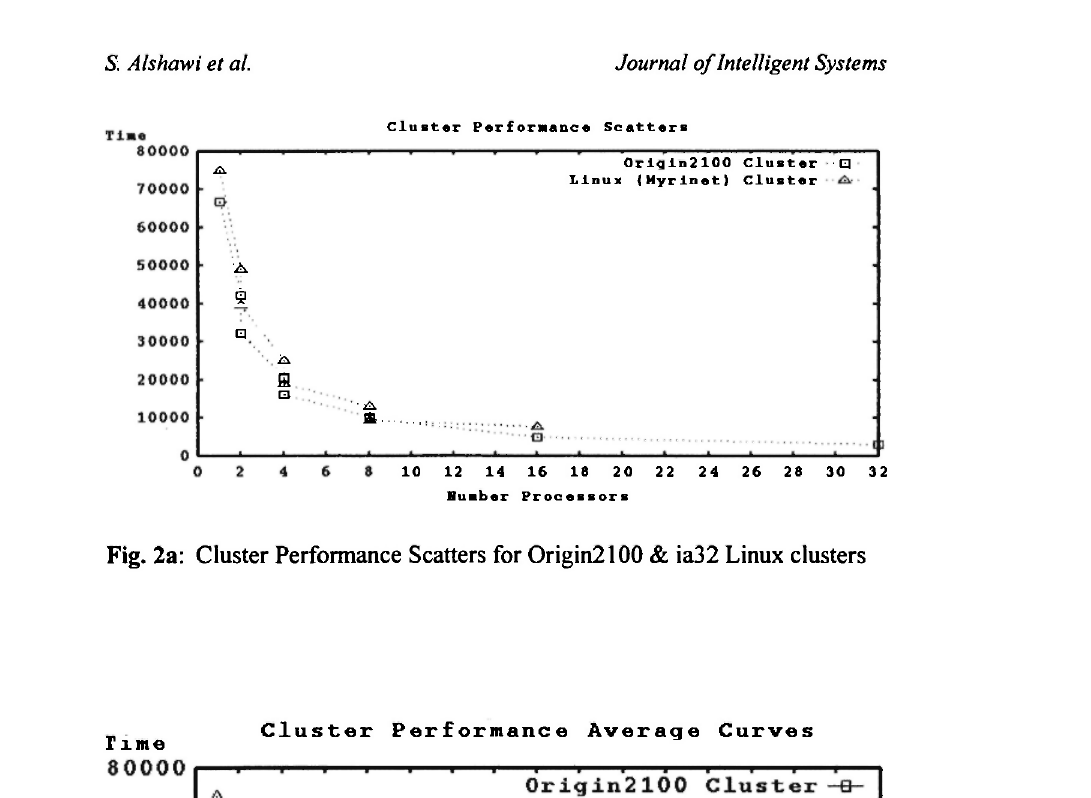
Fig. 2a: Cluster Performance Scatters for 0rigin2100 & ia32 Linux clusters